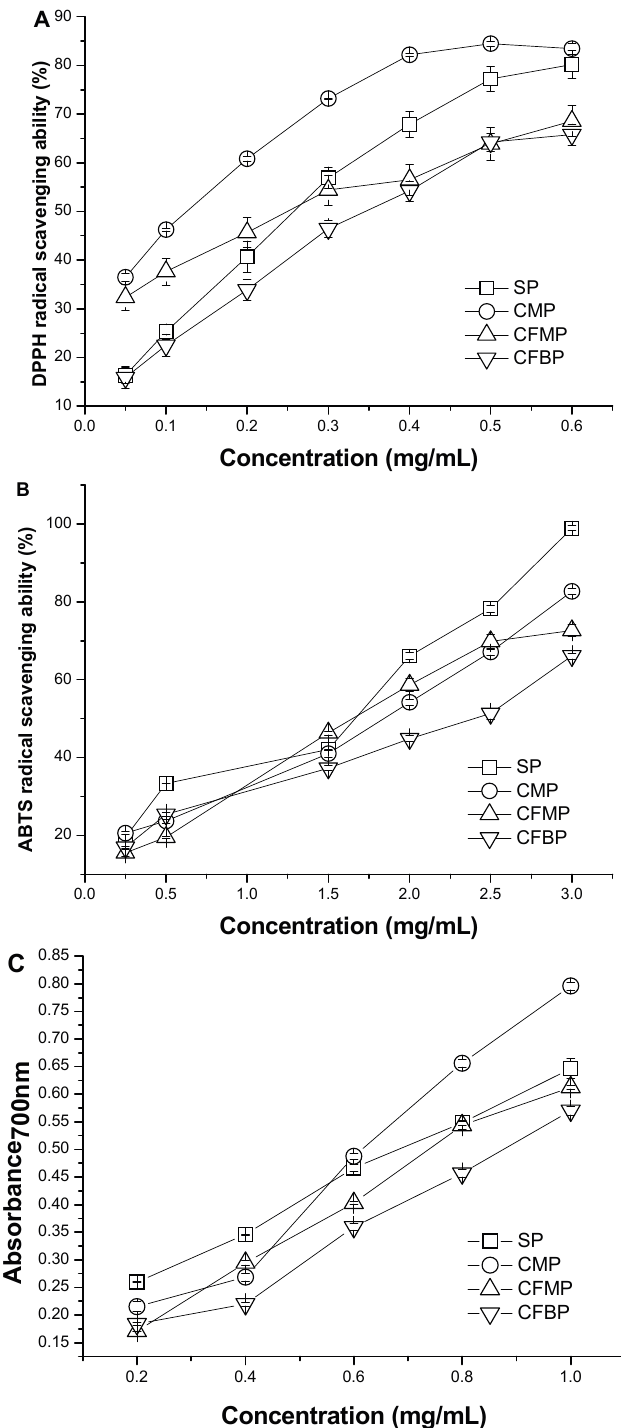
Figure 4. Antioxidant activities of SP, CMP, CFMP and CFBP by scavenging ability for ( A ) DPPH radicals; ( B ) ABTS radicals; and ( C ) reducing